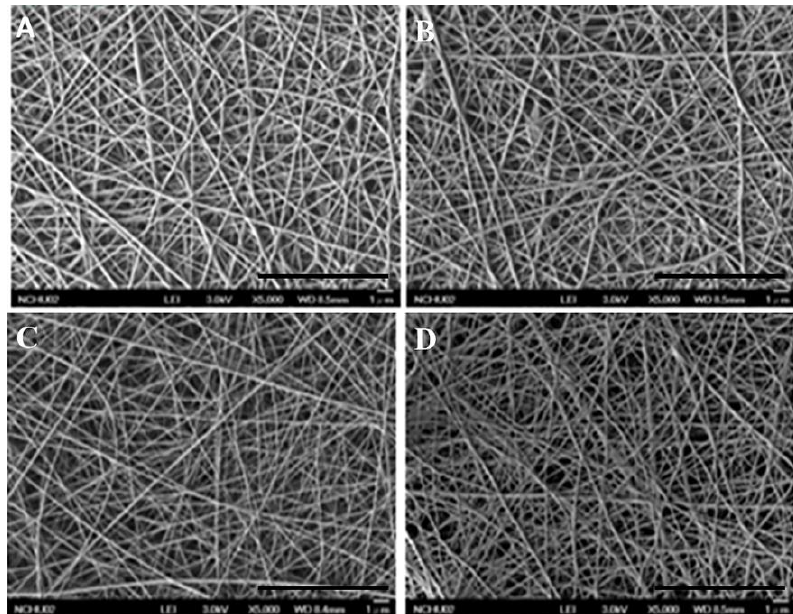
Figure 4. Scanning electron microscopy (SEM) images of various GEL nanofibers. ( A ) GEL, ( B ) GEL / L, ( C ) GEL / C, ( D ) GEL / L / C. Bars: 10 µ m.